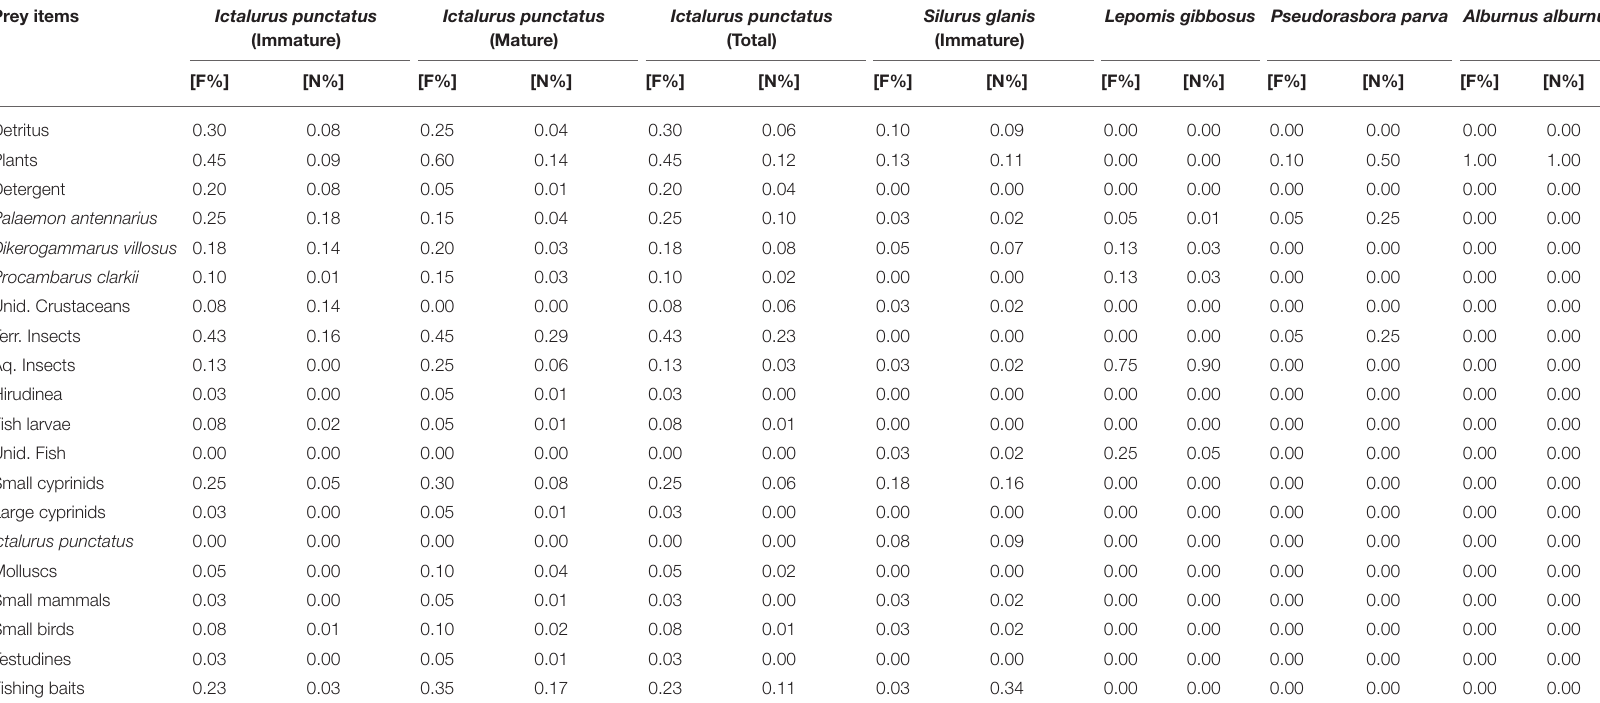
TABLE 1 | Frequency of occurrence (%F), abundance (%N), and prominence value (PV) of food items analyzed for juvenile and mature Ictalurus punctatus , juvenile Silurus glanis . Prey